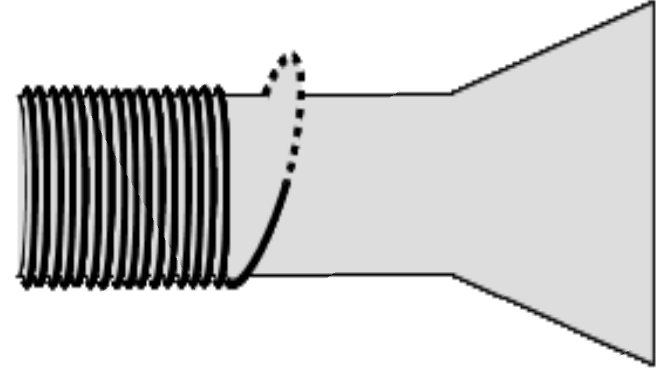
Figure 6. Transverse winding of the carbon fiber on the blank matrix.